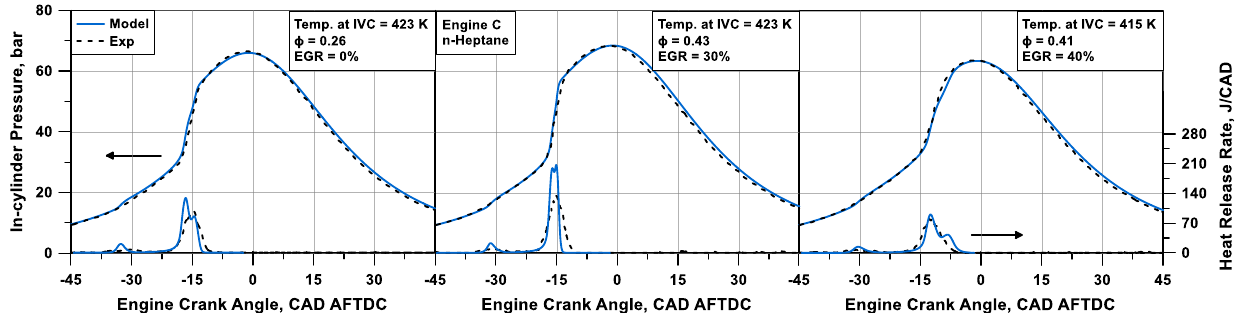
Figure 12. Numerical/experimental comparison of in-cylinder pressure traces and heat release rate profiles for Engine C.